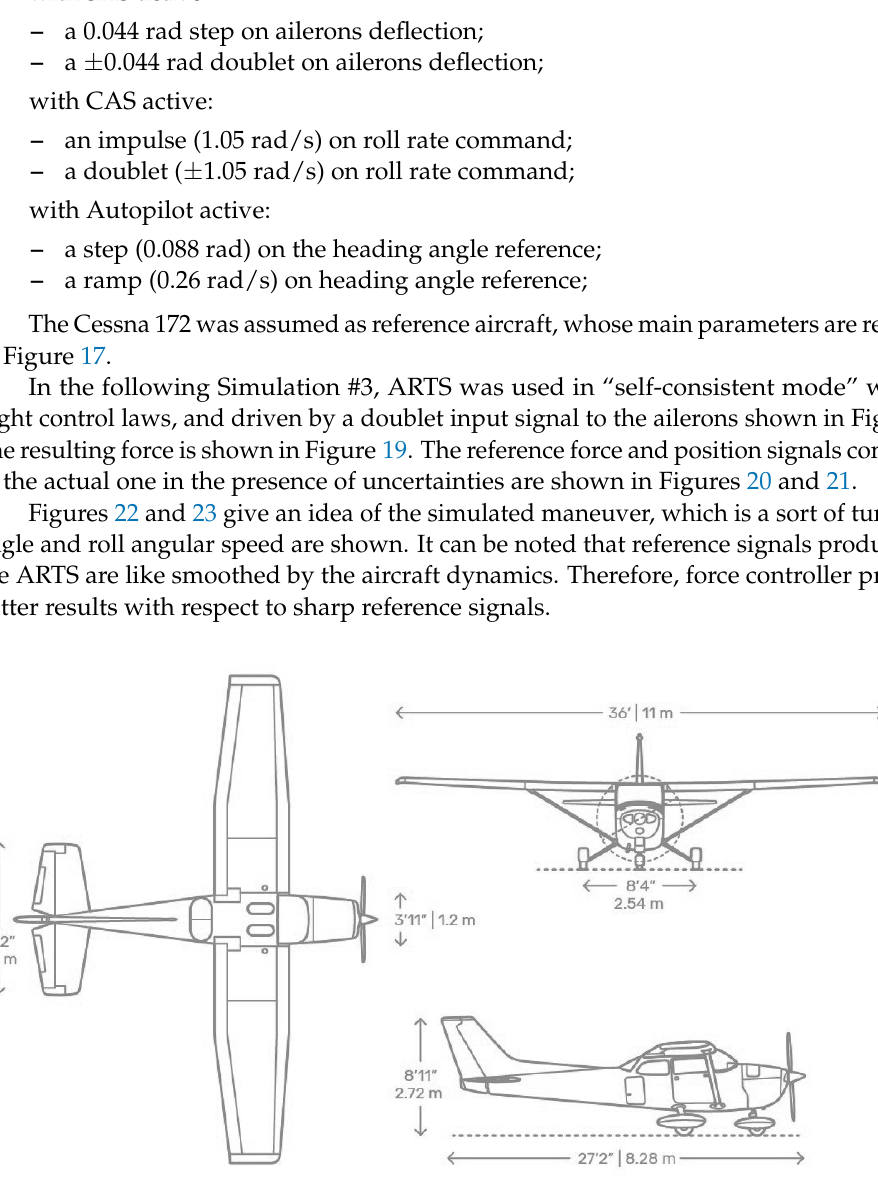
Figure 17. Simulated Aircraft-Cessna